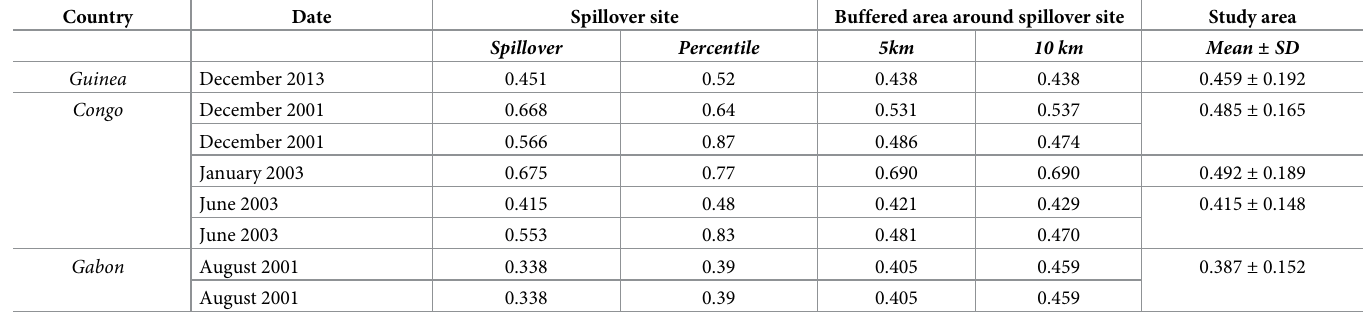
Table 3. Ebolavirus spillover suitability index of sites where spillover events have been previously reported compared to the values (mean and standard deviation) of the whole study area. The percentile of suitability index for the spillover site is shown. Country